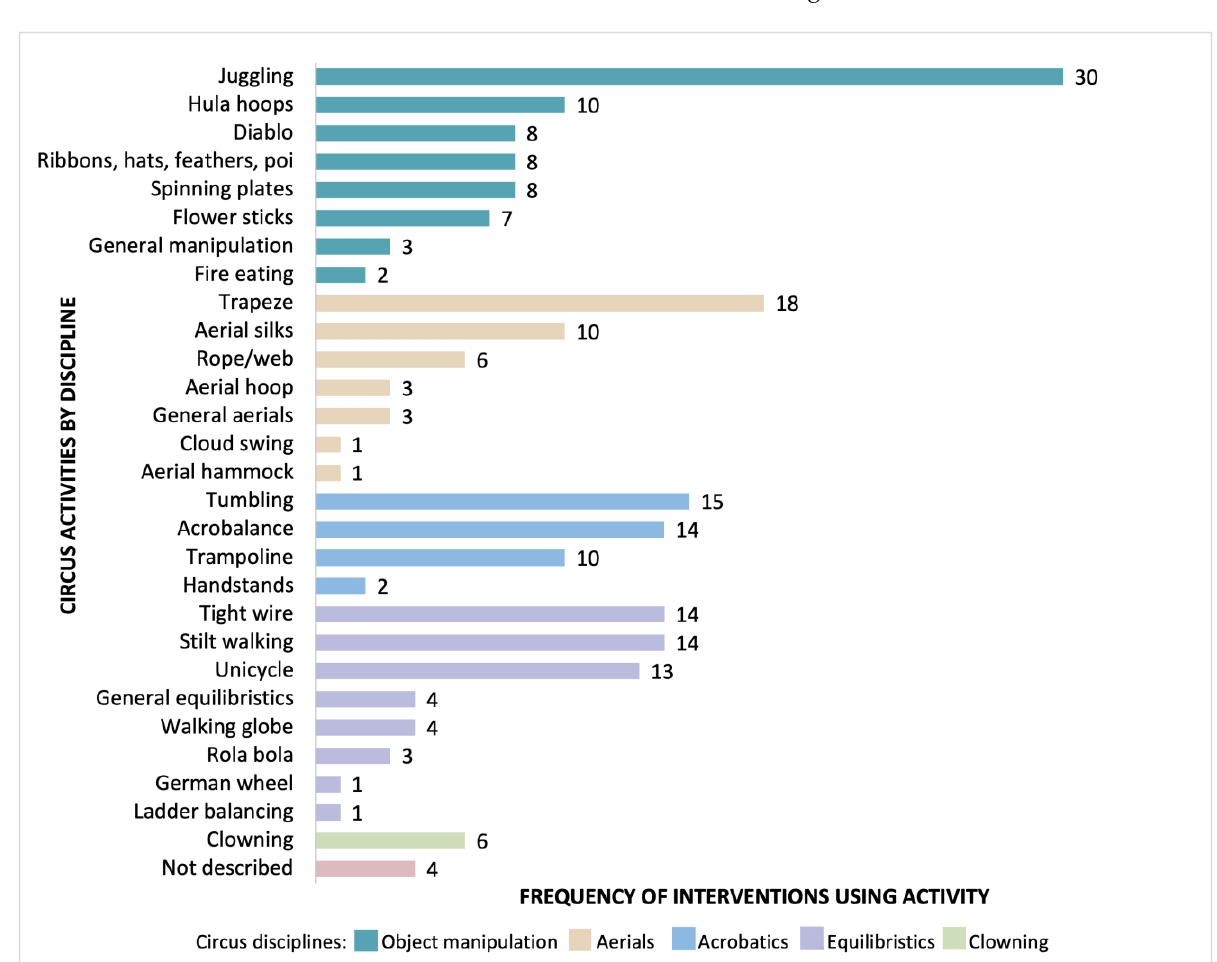
Figure 3. Circus activities utilised in interventions.